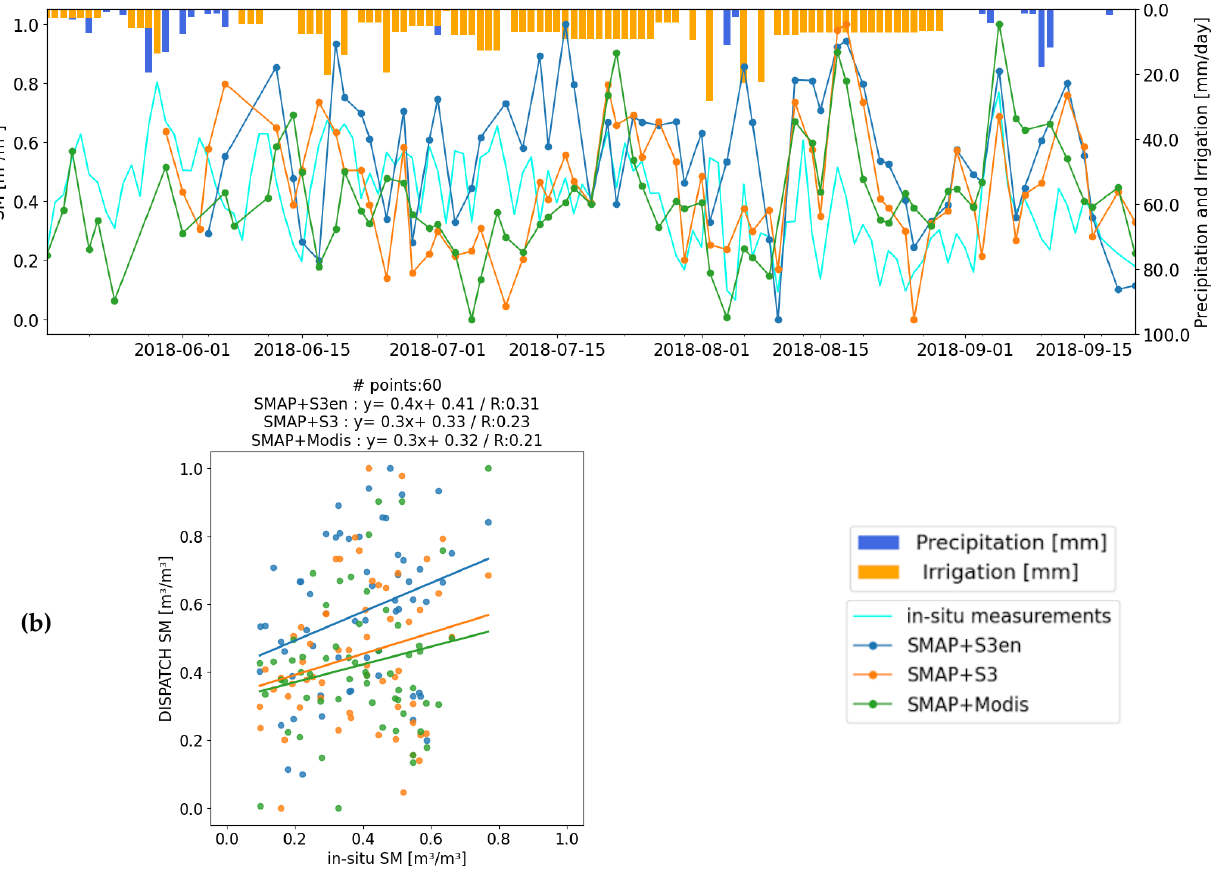
Figure 4. Same description as for Figure 3. ( a ) Time series of SSM products (in situ and DisPATCh products) that correspond to the data extracted in 2018 for the Raimat field. ( b ) Scatter plot of in situ data compared with the three DisPATCh products (same colors as for Figure 4a).